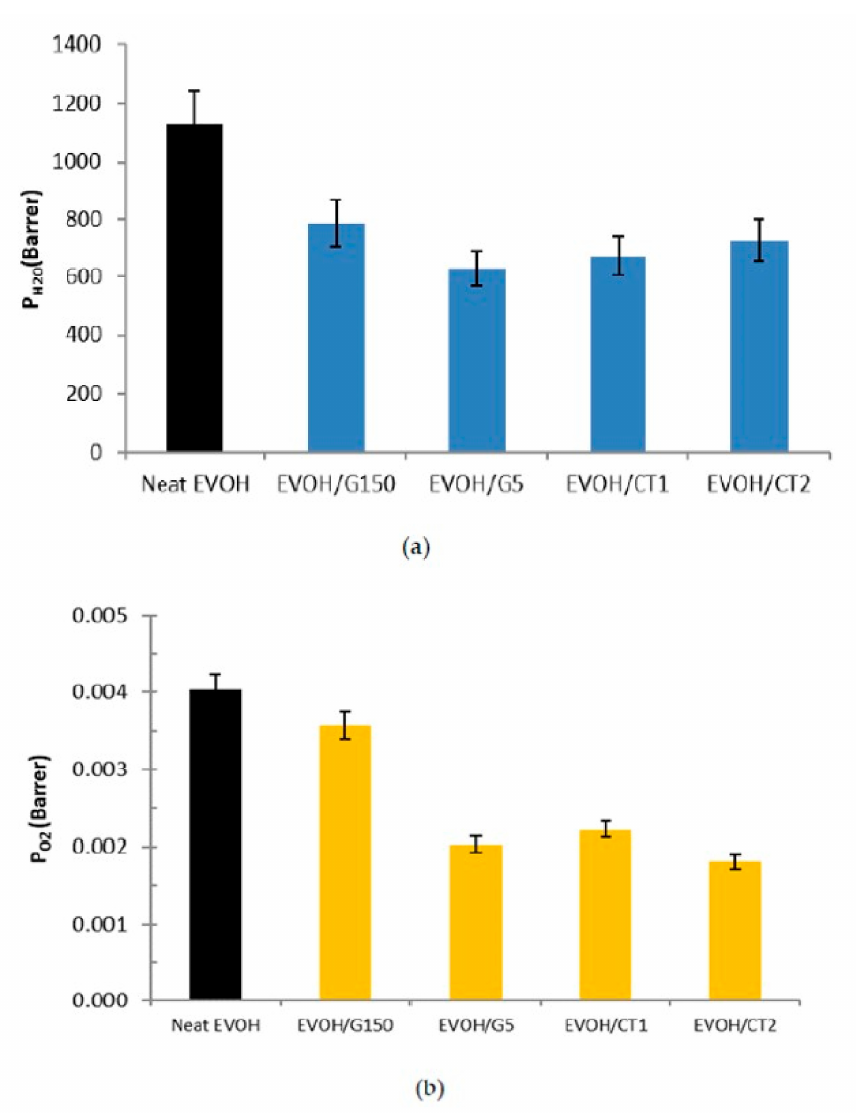
Figure 7. Comparison of the ( a ) water and ( b ) oxygen permeability coefficients of the neat EVOH and studied nanocomposites ( T = 25 ◦ C, a w = 1, filler rate = 2